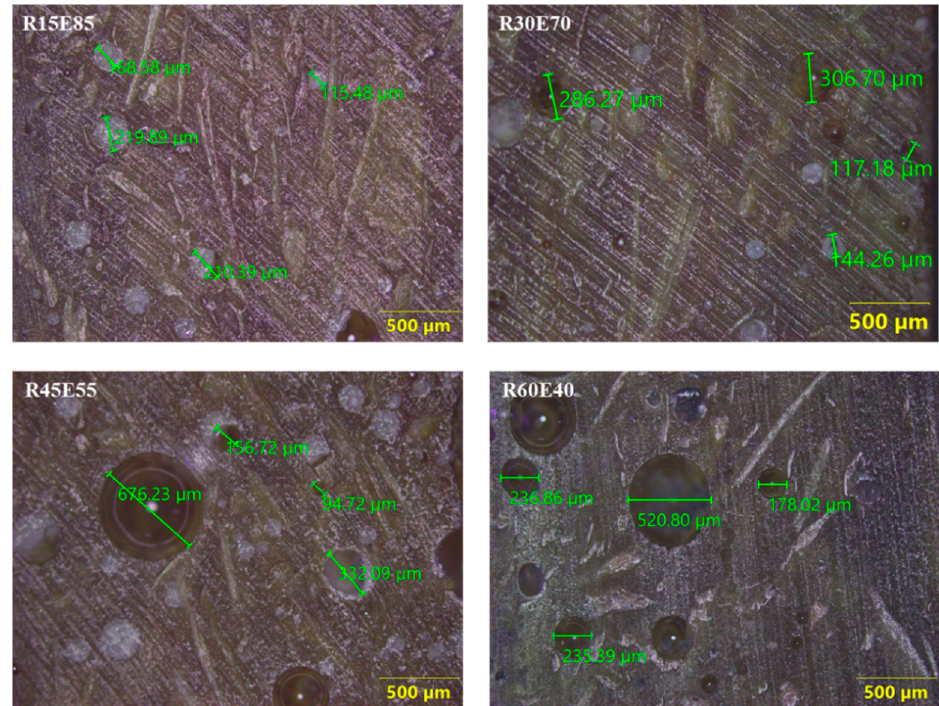
Figure 6. Optical microscope images of voids in the test samples.